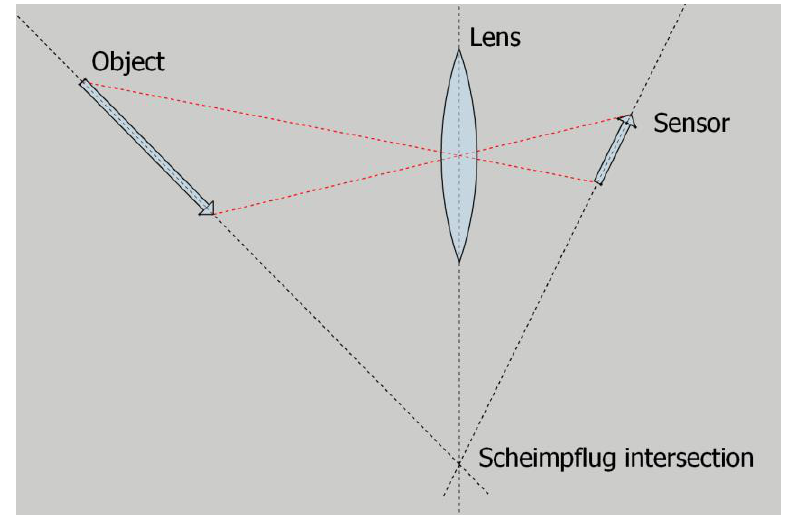
Figure 5. Demonstration of the Scheimpflug principle.